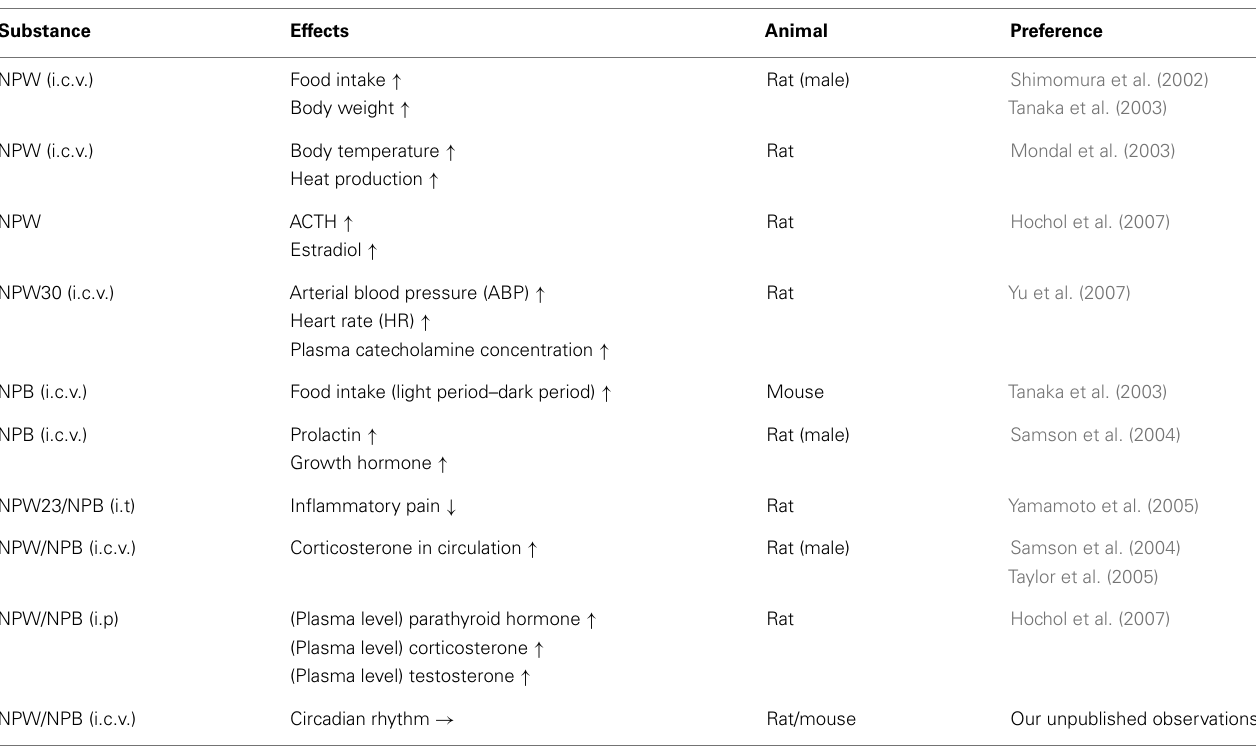
Table 1 | In vivo pharmacological effects of NPB/NPW.